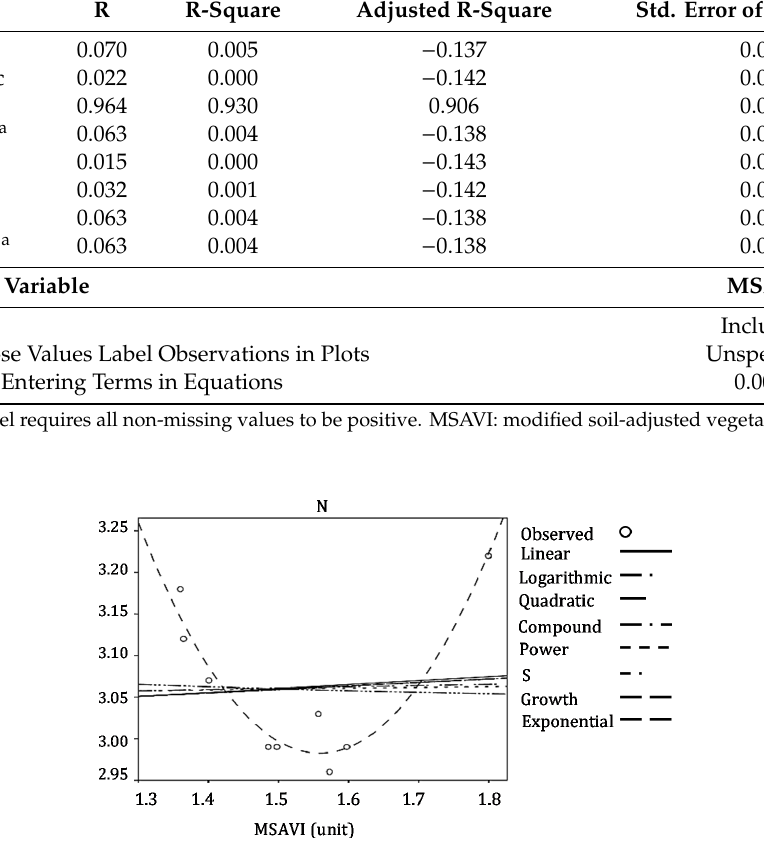
Table 8. Model summary of modified soil-adjusted vegetation index (MSAVI) in SPSS software.